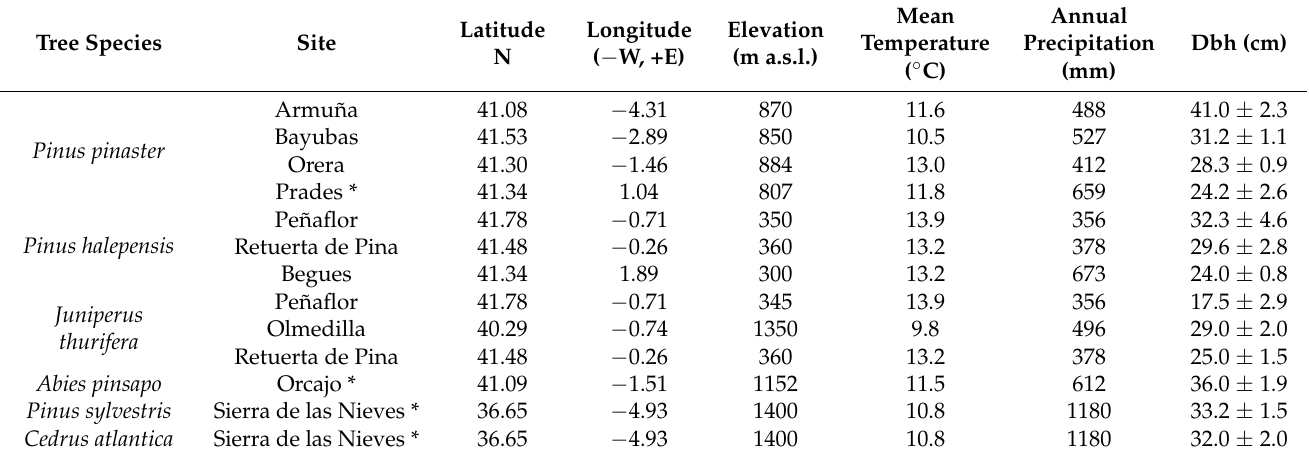
Table 1. Study species and sites where tree-ring chronologies were developed to quantify the annual percentage of IADF production in the latewood. The sites with asterisks (*) correspond to plantations. Dbh is the diameter at breast height (mean ±